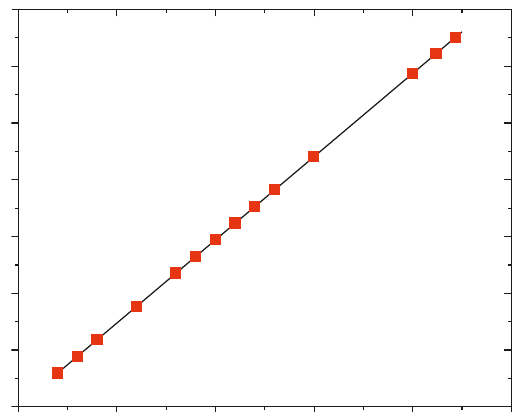
Figure 4: Curve of stress dependence on